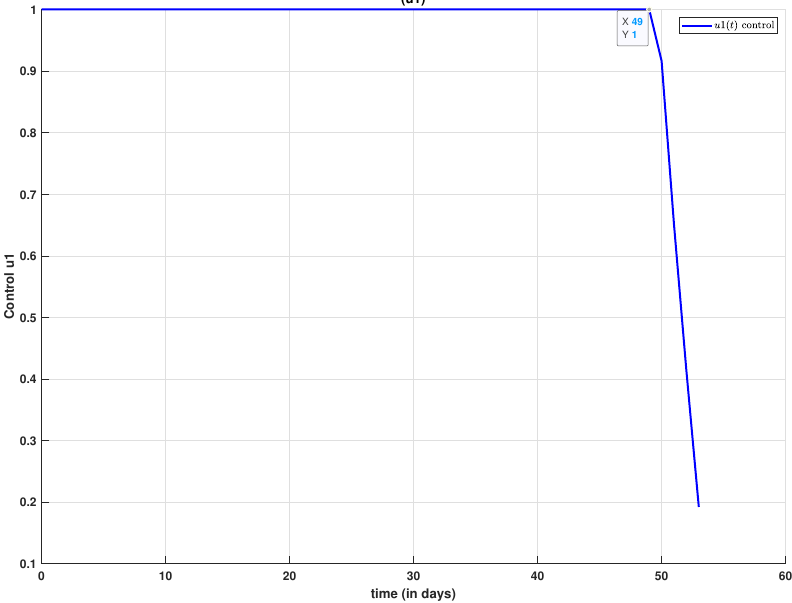
Figure 7. Evolutionary dynamics of the control u 1 ( t )